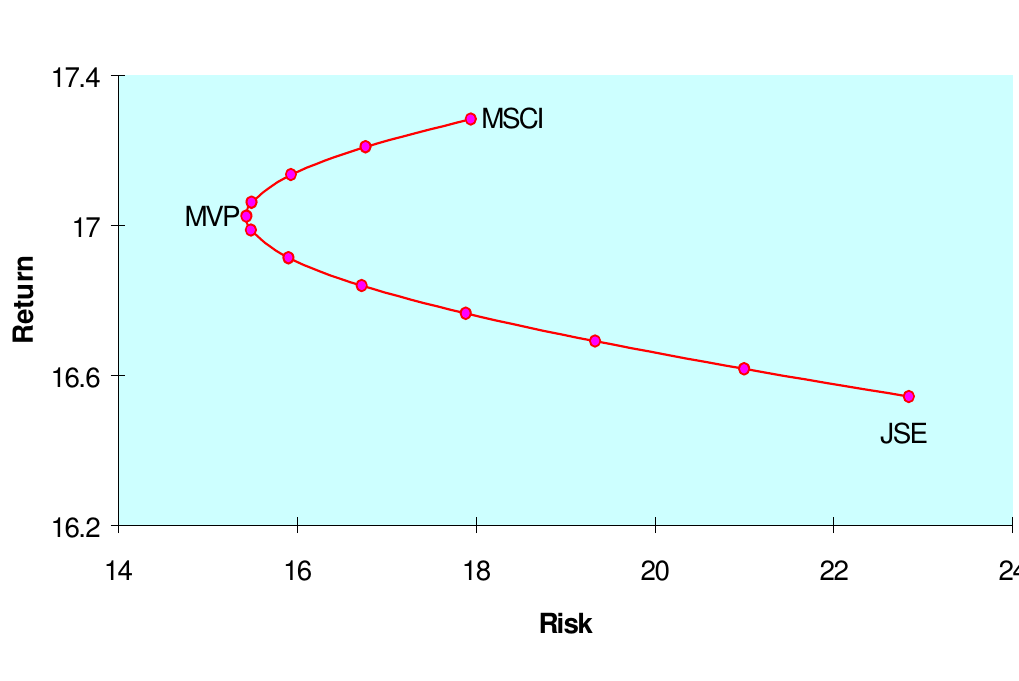
Figure 3: Efficient Frontier